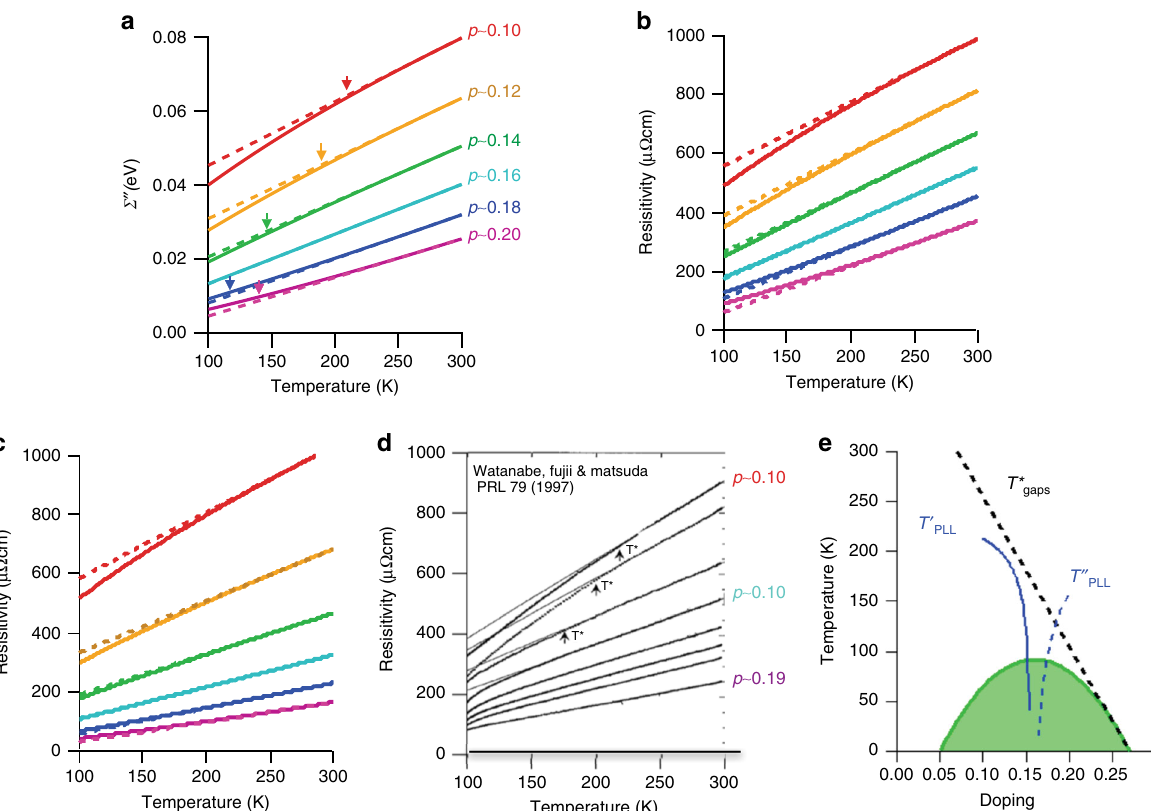
Fig. 4 Scattering rates, resistivity, and apparent temperature scales. a Calculated doping and temperature dependence of the nodal Σ ” ( ω ) (solid line) in the ω = 0 limit using the linear relation between α and doping level p . Low temperature extrapolations from linear fi ts between [250 K, 300 K] are extrapolated as dashed lines. Additionally, Γ 0 = 0, β = π , and λ = 0.5 for all curves. b , c Resistivity as a function of temperature and doping calculated using two different methods (solid lines, see text for details). Linear extrapolations from [250 K, 300 K] are shown as dashed lines. The temperature dependence is dominated by the temperature dependence of Σ ” . d Resistivity measurements from Watanabe et al. as well as the “ pseudogap ” temperature scale T* 22 . e Compilation of the “ break ” temperatures from panel a: T ’ and T ” are temperatures where there is an apparent break in Σ ” from the more linear form that is observed at high temperatures (up to 300